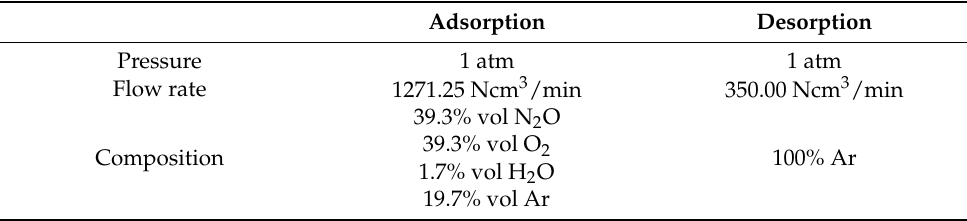
Table 3. Operating conditions of the wet mixture (with O 2 ) in adsorption and